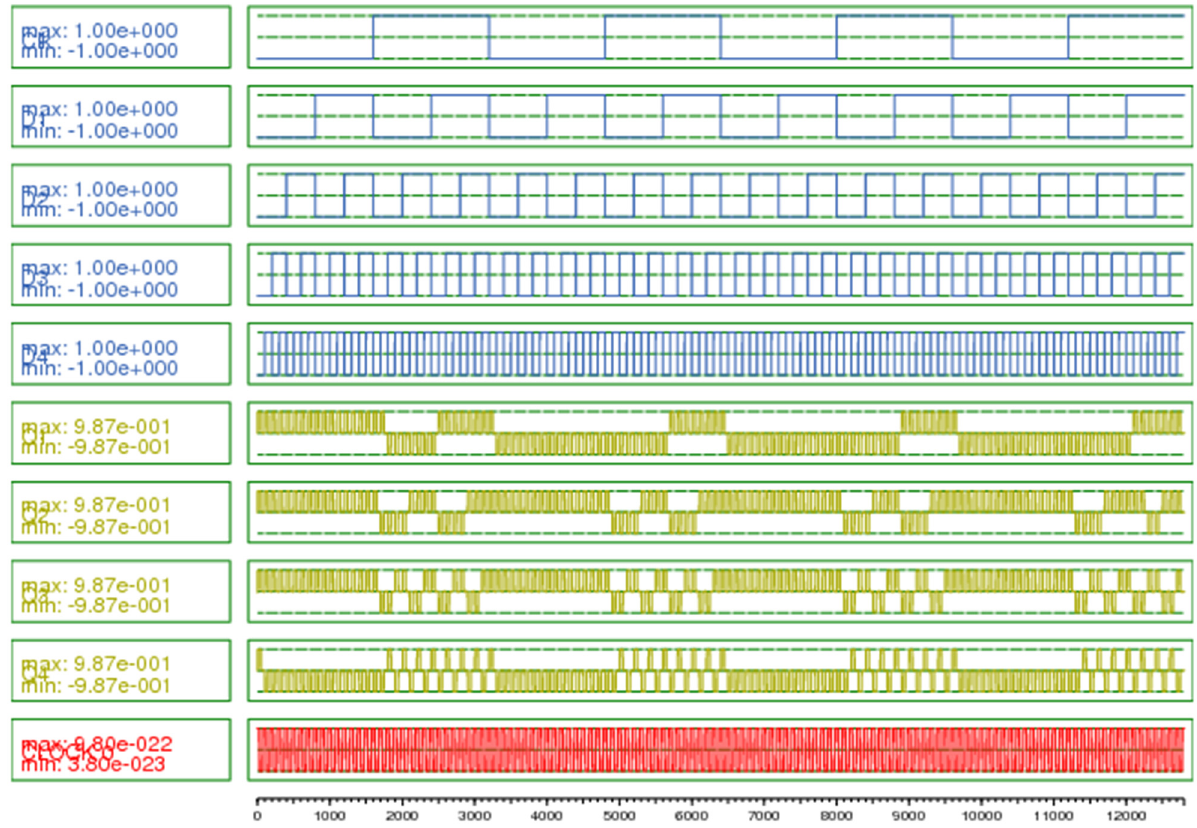
Figure 14. Simulation graph of 4-bit PIPO shift register. Table 1. Performance parameters of proposed PIPO shift